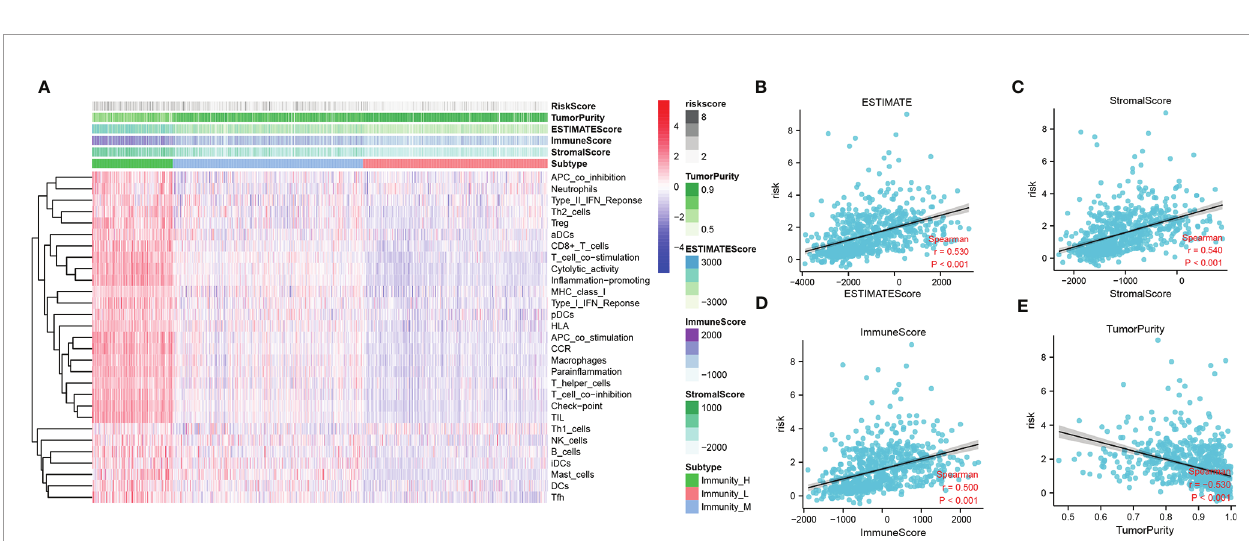
FIGURE 8 | Relationship between immune cell in fi ltration and risk score. (A) Heatmap of ssGSEA and correlation between risk and ESTIMATE, immune, and stromal scores, and tumor purity. (B) Correlation of risk and ESTIMATE scores. (C) Correlation of risk and stromal scores. (D) Correlation of risk and immune scores. (E) Correlation of risk and tumor purity